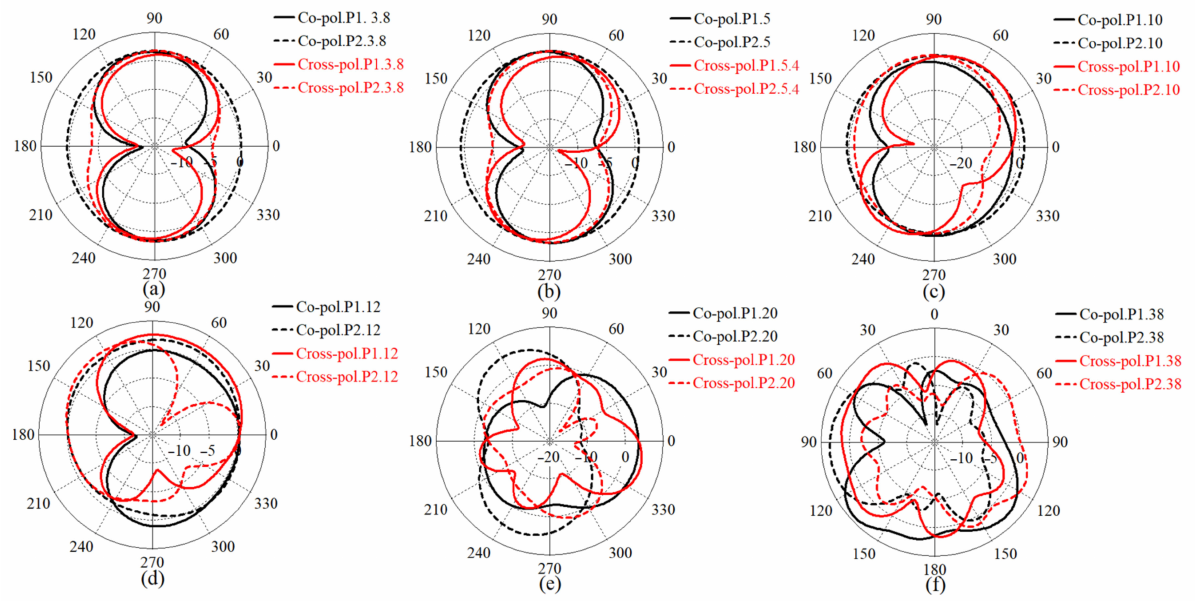
Figure 9. The radiation patterns of MAVA antenna considering both Ant 1 and Ant 2 at: ( a ) 3.8 GHz, ( b ) 5.4 GHz, ( c ) 10 GHz, ( d ) 12 GHz, ( e ) 20 GHz, and ( f ) 38 GHz before combination and